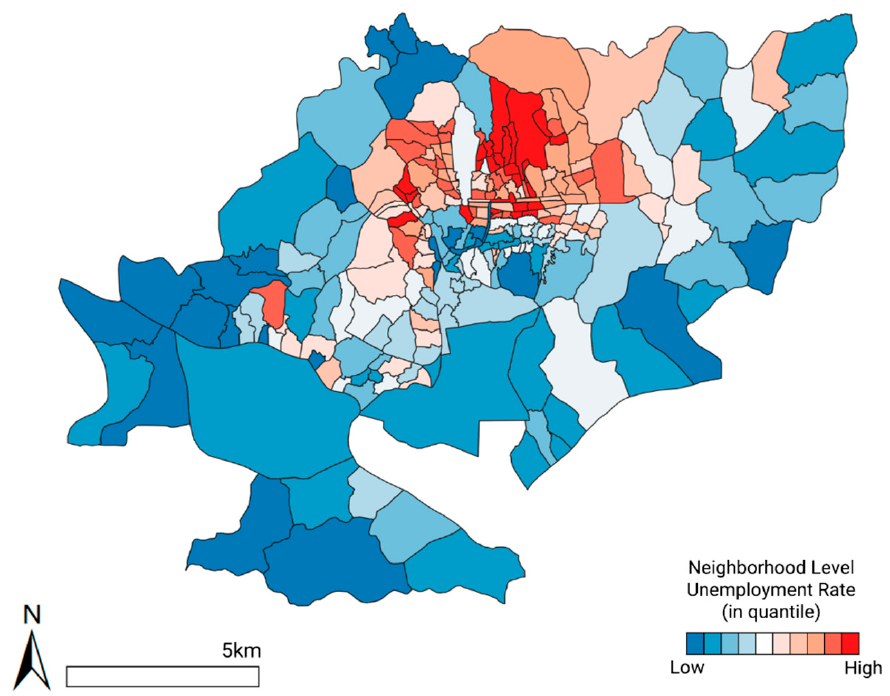
Figure 6. Neighborhood level unemployment rate of the study area. However, when we focused on certain specific local neighborhoods, we observed in‑ teresting findings. Figure 6 is a Getis‑Ord GI* cluster map of the unemployment rate. The red color indicates significant high clusters (i.e., clusters of higher unemployment rates), while the blue color indicates significant low clusters (i.e., clusters of lower unemploy‑ ment